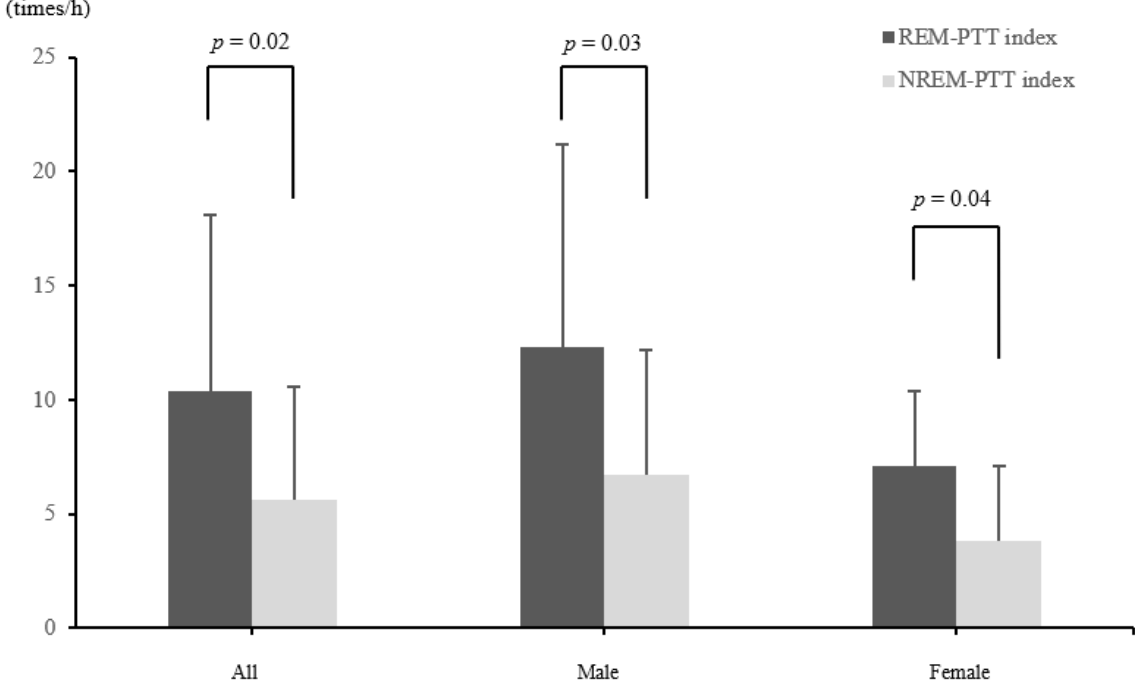
Figure 1. A comparison of PTT indexes during REM and NREM sleep. Continuous variables are expressed as mean ± stan- dard deviation (SD). A comparison of the REM-PTT index and the NREM-PTT index ( p < 0.05) was considered statistically